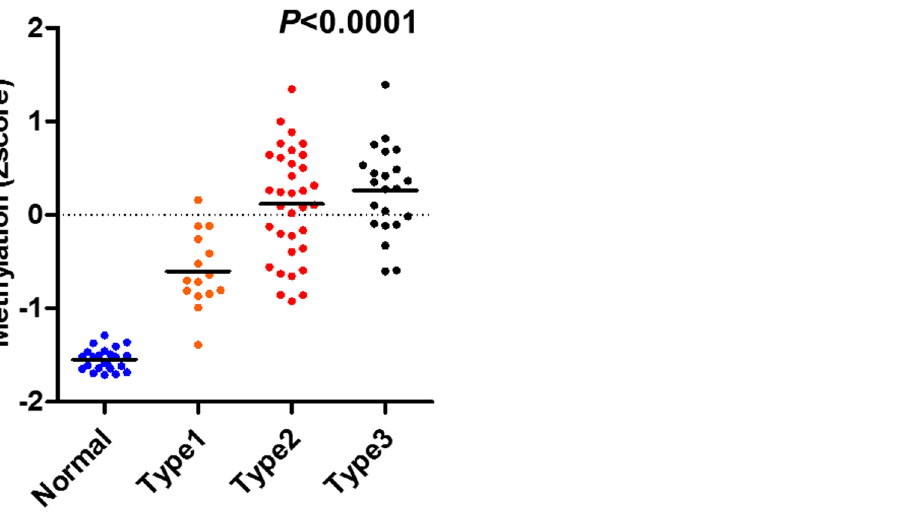
Figure 2. Mean Z score methylation of nine candidate genes in relation to the NBI mucosal patterns. Statistical analysis was performed using the Spearman correlation